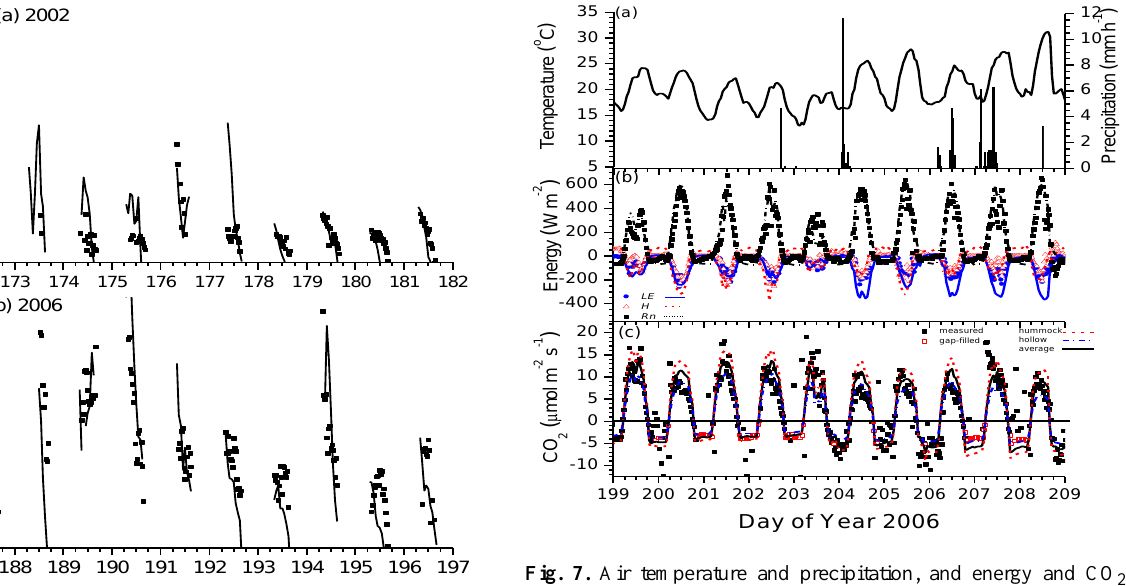
Fig. 7. Air temperature and precipitation, and energy and CO 2 fluxes measured (symbols) and modelled (lines) before and after precipitation events with a low water table from DOY 200 to 209 in 2006 (0.7m in Fig. 2). Positive values represent downward fluxes, negative values represent upward